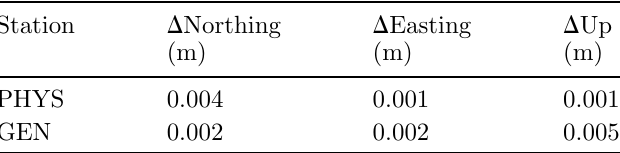
Table 10. Differences in the North, East, Up components